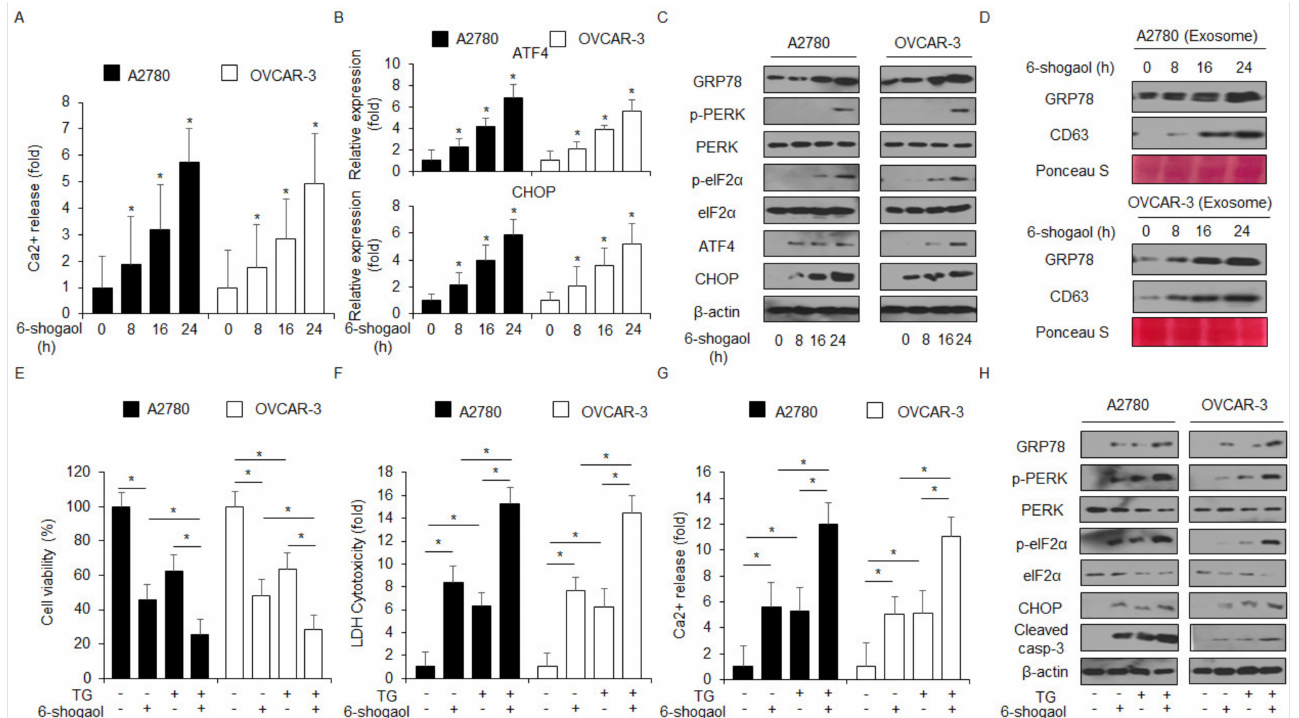
Figure 3. 6-shogaol mediates ER stress response through intracellular Ca 2+ generation. ( A ) A2780 and OVCAR-3 cells were treated with 6-shogaol (30 µ M) in a time-dependent manner (0, 8, 16, and 24 h) and intracellular Ca 2+ release was determined using an intracellular Ca 2+ assay. ( B ) A2780 and OVCAR-3 cells were treated with 6-shogaol (30 µ M) in a time-dependent manner (0, 8, 16, and 24 h) and mRNA levels of ATF4 and CHOP were investigated using real-time RT-PCR. ( C ) A2780 and OVCAR-3 cells were treated with 6-shogaol (30 µ M) for the indicated times (0, 8, 16, and 24 h) and the activation of ER stress signaling, including GRP78, p-PERK, PERK, p-eIF2 α , eIF2 α , ATF4, and CHOP, was assessed using the Western blot assay. β -actin was used as a protein loading control. ( D ) A2780 and OVCAR-3 cells were treated with 6-shogaol (30 µ M) for the indicated times (0, 8, 16, and 24 h) and exosomes were extracted from the cell culture media. Protein samples extracted from cell lysates and exosomes were quantified by Ponceau S staining. These samples were conducted by Western blotting using the ER stress marker, GRP78, and the exosome marker, CD63. ( E – H ) Cell viability, LDH cytotoxicity, and expression levels of GRP78, p-PERK, PERK, ATF4, CHOP, and cleaved caspase-3 levels were determined using WST-1 assay, LDH assay, and Western blotting analyses in thapsigargin (TG; 3 µ M, 24 h) and 6-shogaol (30 µ M, 24 h)-treated A2780 and OVCAR-3 cells; *, p